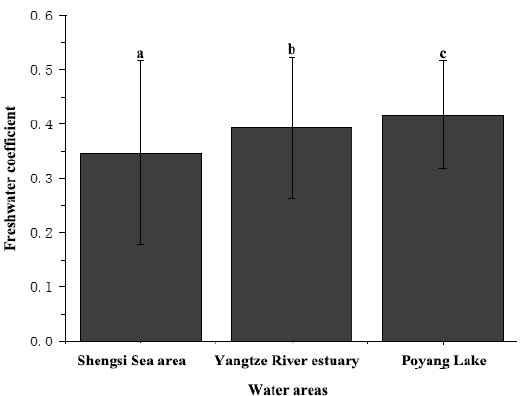
Figure 8. Freshwater coefficient of Coilia nasus in each water area (different letters indicate significant differences, p < 0.05).